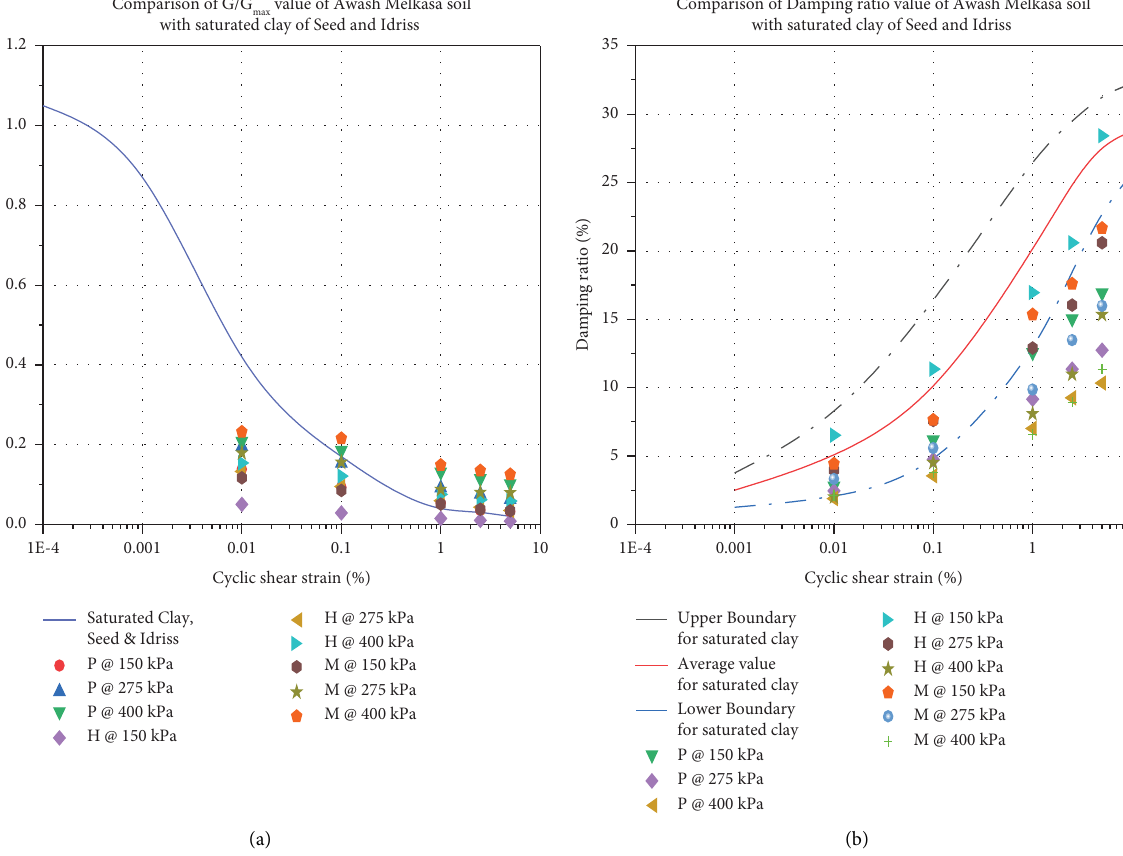
values and (b) damping ratio values